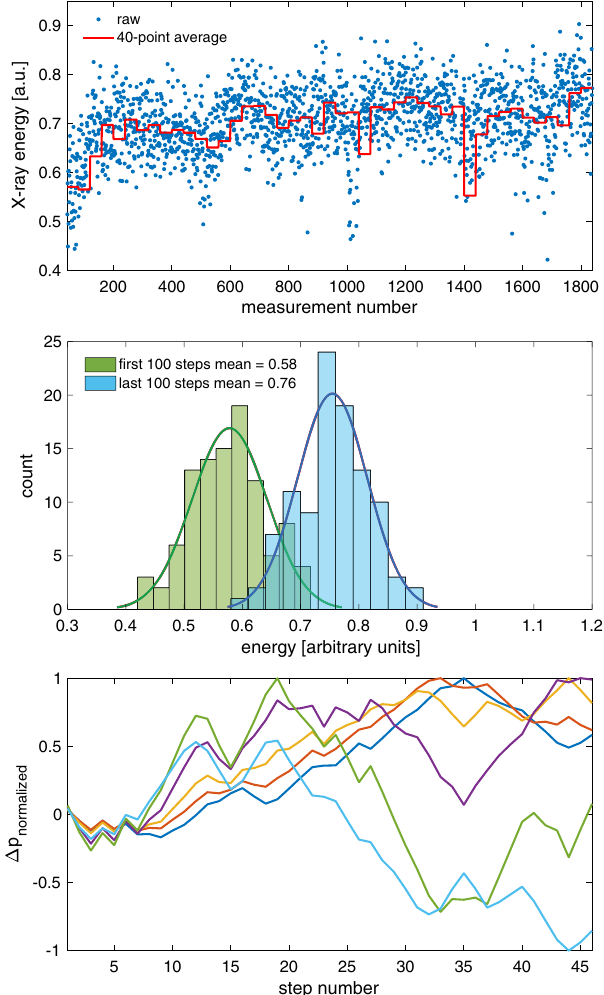
FIG. 11. The evolution of the output power (arbitrary units) and its 40-point moving average is shown alongside the normalized FEL parameter